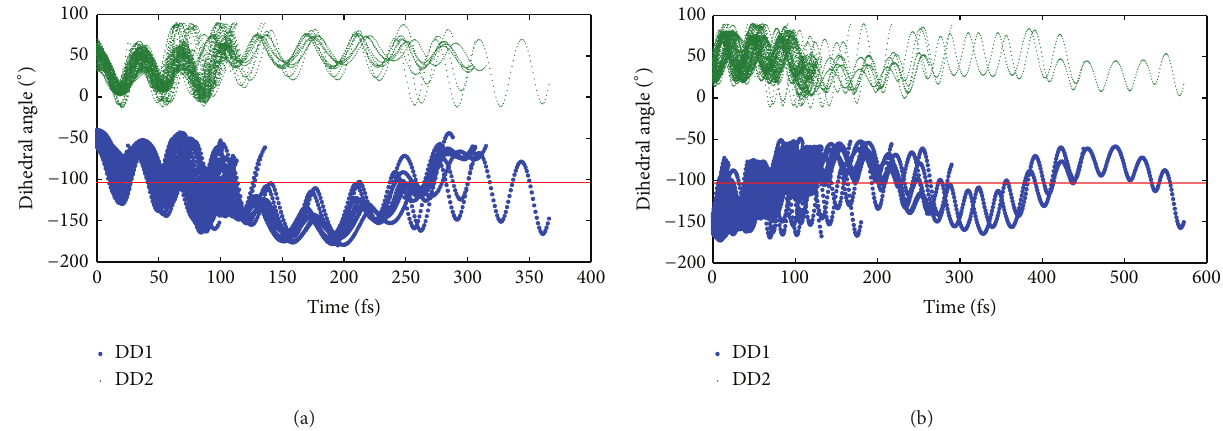
Figure 6: The dihedral angels DD1 and DD2 vary with time for 100 trajectories; (a) and (b) correspond to initially start from cis-area and trans-area,